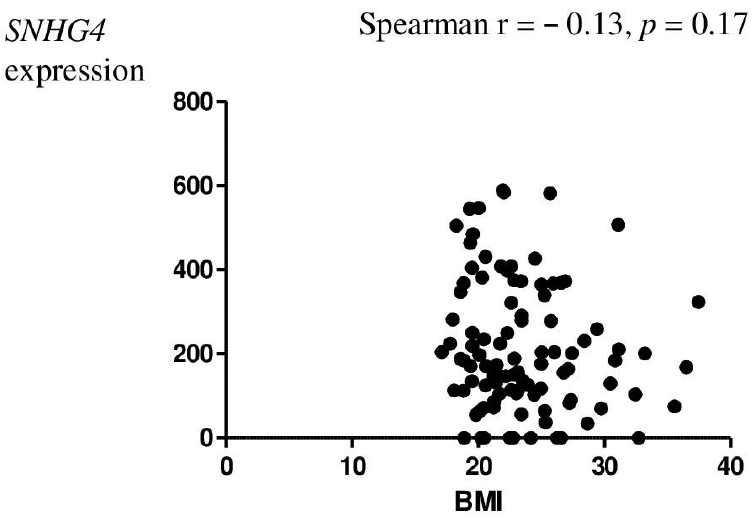
Figure 3. Correlation between patient BMI and relative expression of the SNHG4 gene.